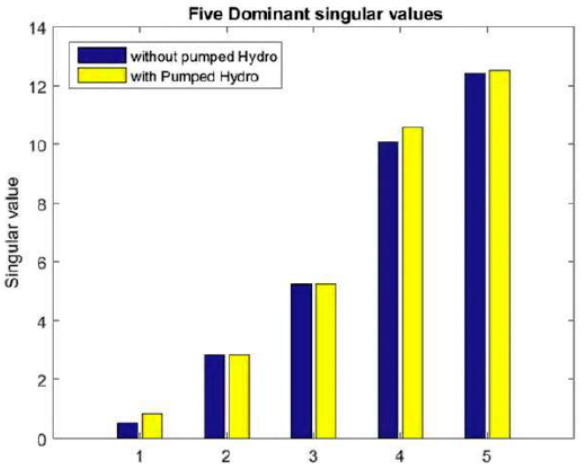
Figure 14. Result plot with and without PHG: Period